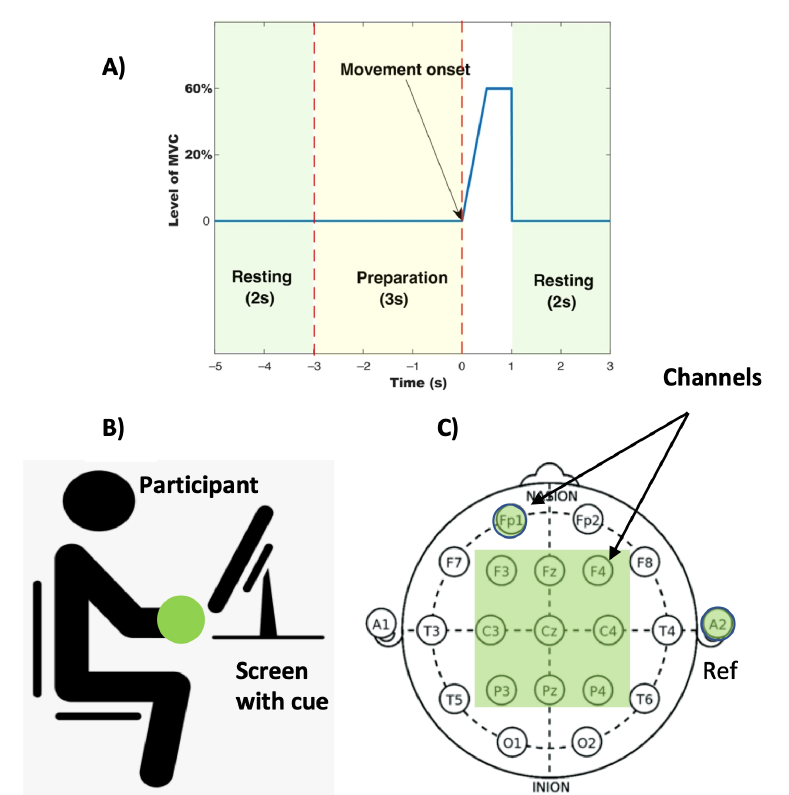
Figure 1. ( A ) Visual cue provided to the participants. The template was displayed during the whole trial. A moving cursor was shown to help the subjects to follow the template. The output of the force transducer was used as moving cursor during motor execution; in case of motor imagination task, the cursor moved over the template to cue the subjects. ( B ) Sketchy representation of the location of the subject during the experiment. ( C ) Indication of the considered EEG